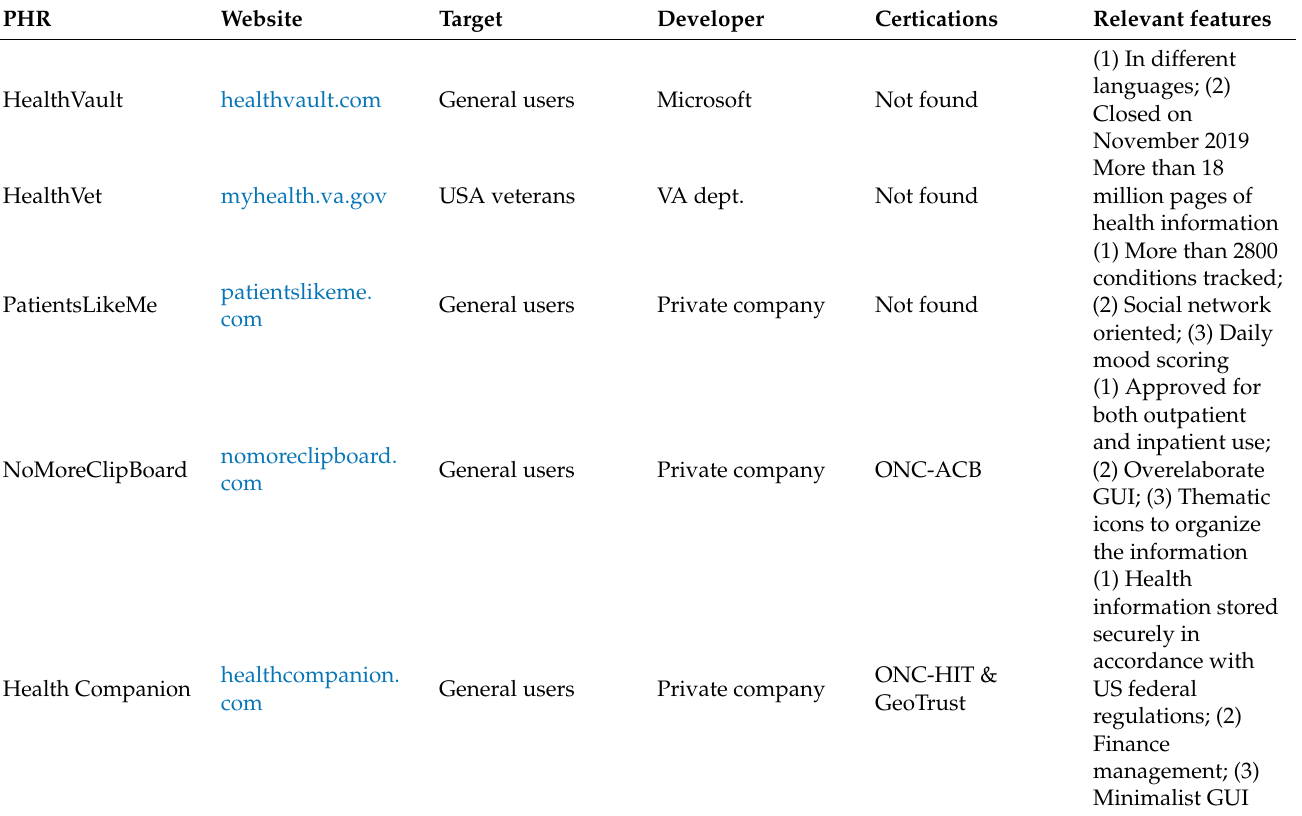
Table 1. Features of the selected